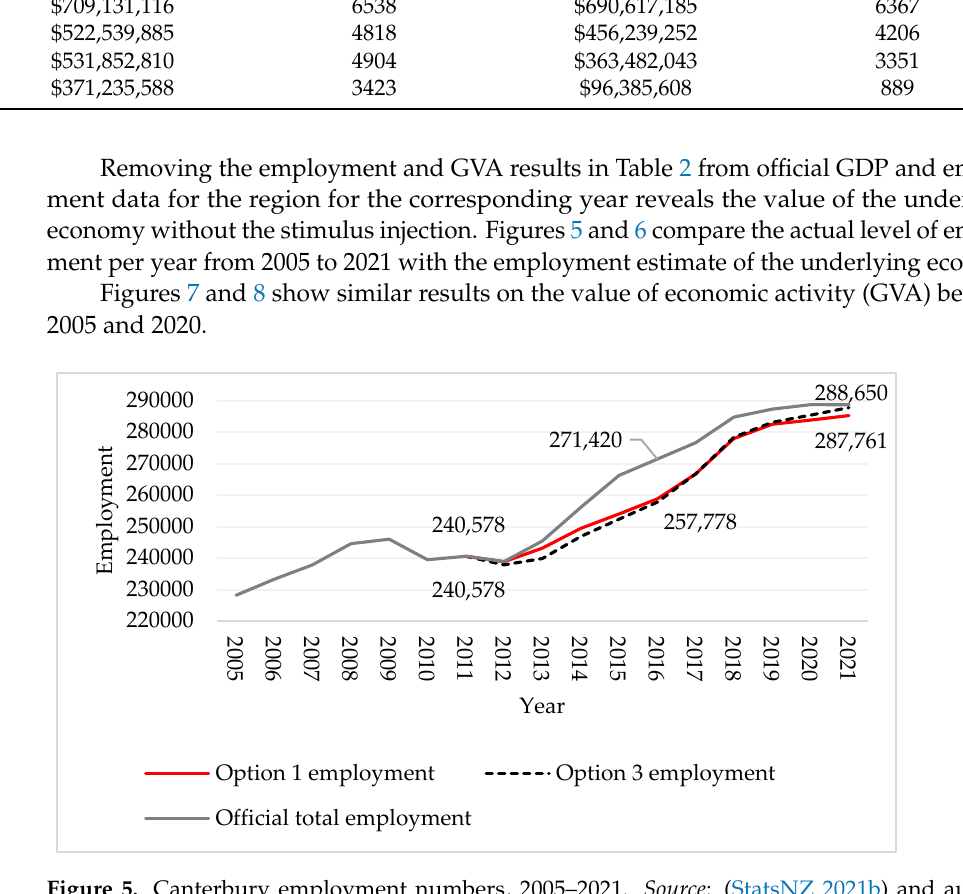
Figure 6. Canterbury employment growth, 2004–2021. Source : (StatsNZ 2021b) and author’s calcu- lations. Figures 7 and 8 show similar results on the value of economic activity (GVA) between 2005 and 2020.